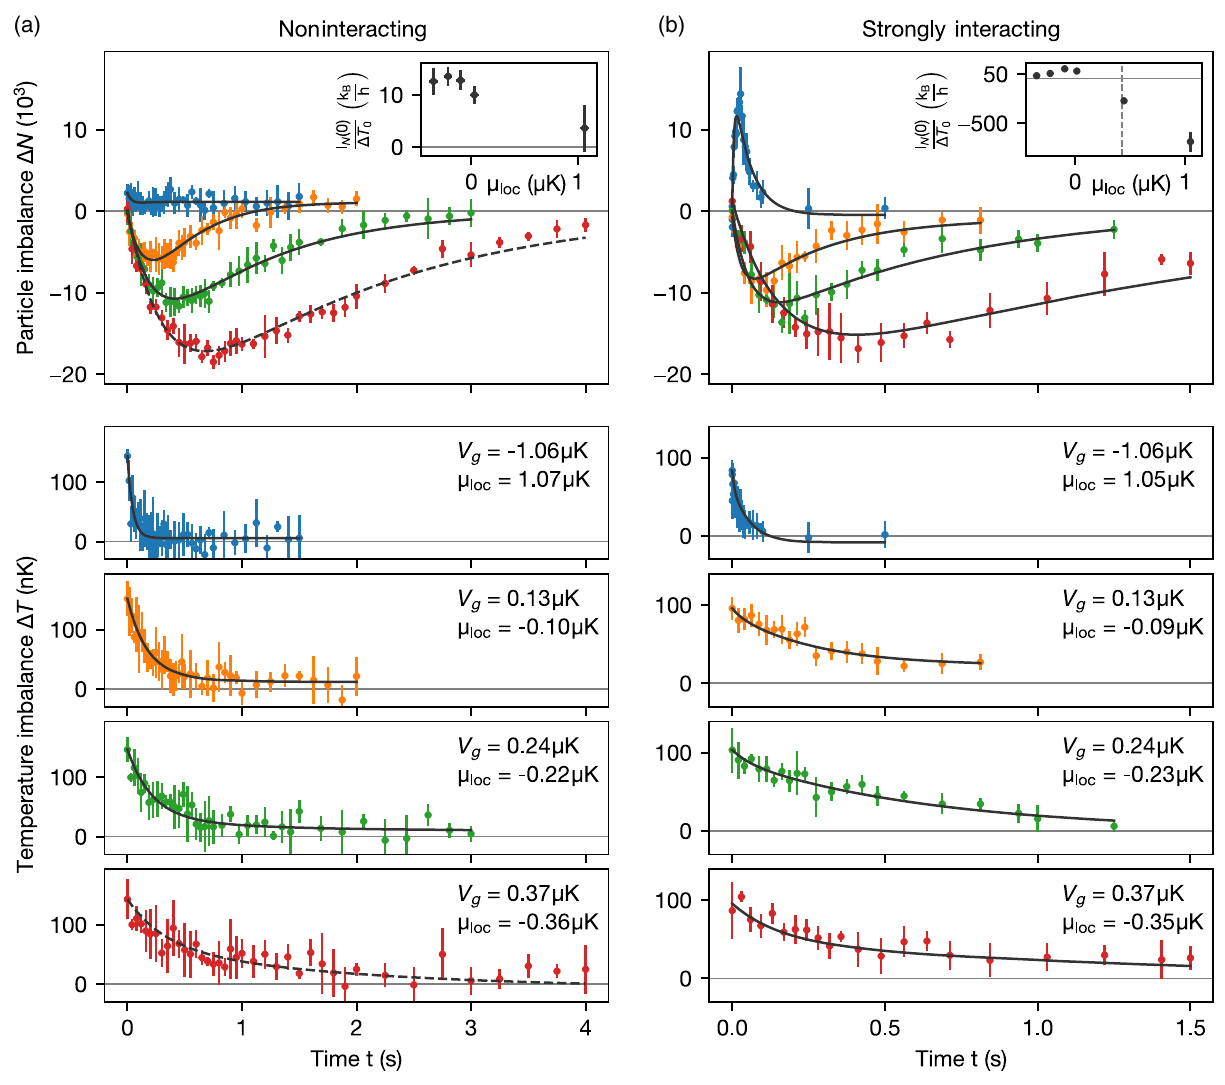
− N and temperature L R . g , and Lorenz number L (Sec. V). For all c μ at the 0 versus local chemical potential loc